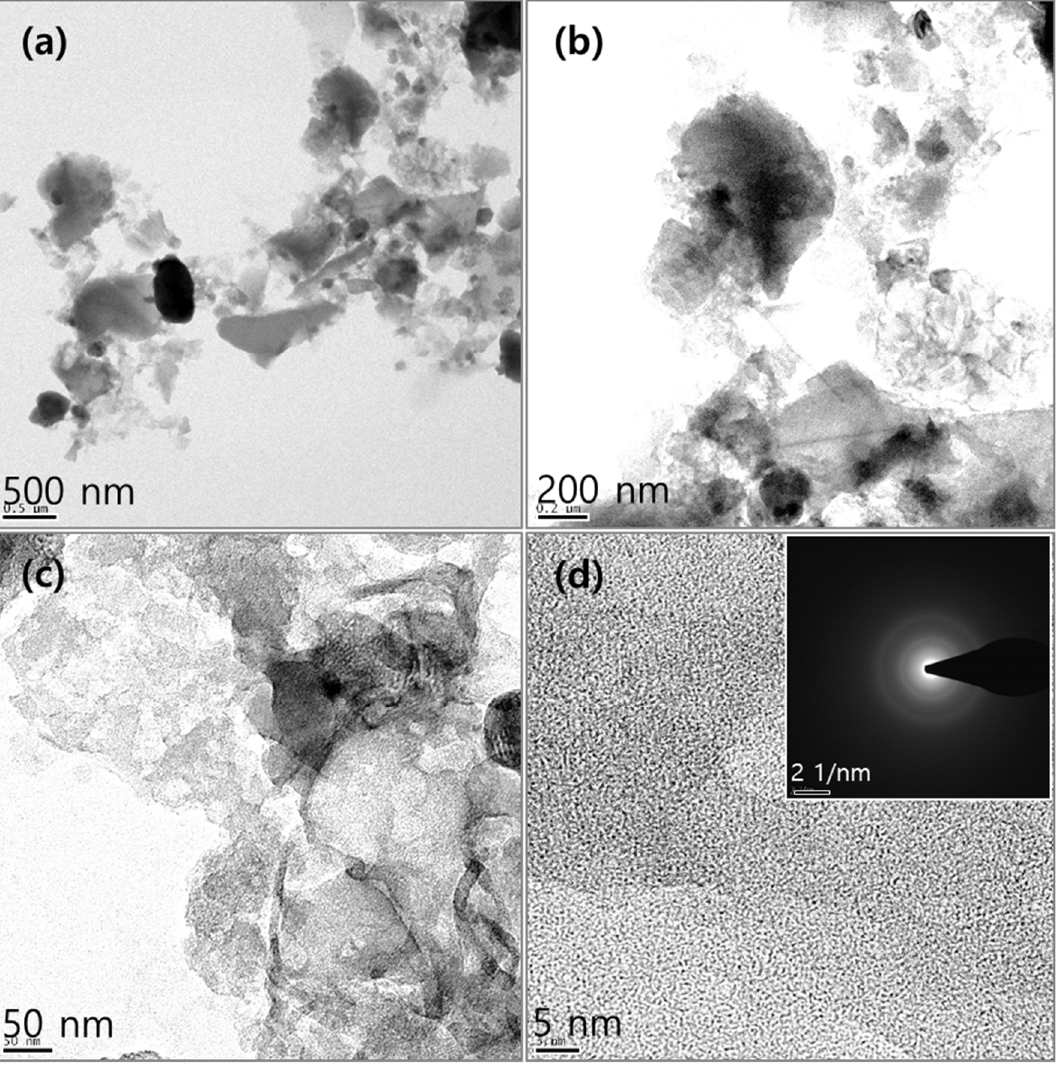
Figure 2. ( a – d ) TEM/HRTEM images at different magnifications of synthesized H ‐ PCM (inset ( d ): SAED pattern of H ‐ PCM). ( d ): SAED pattern of